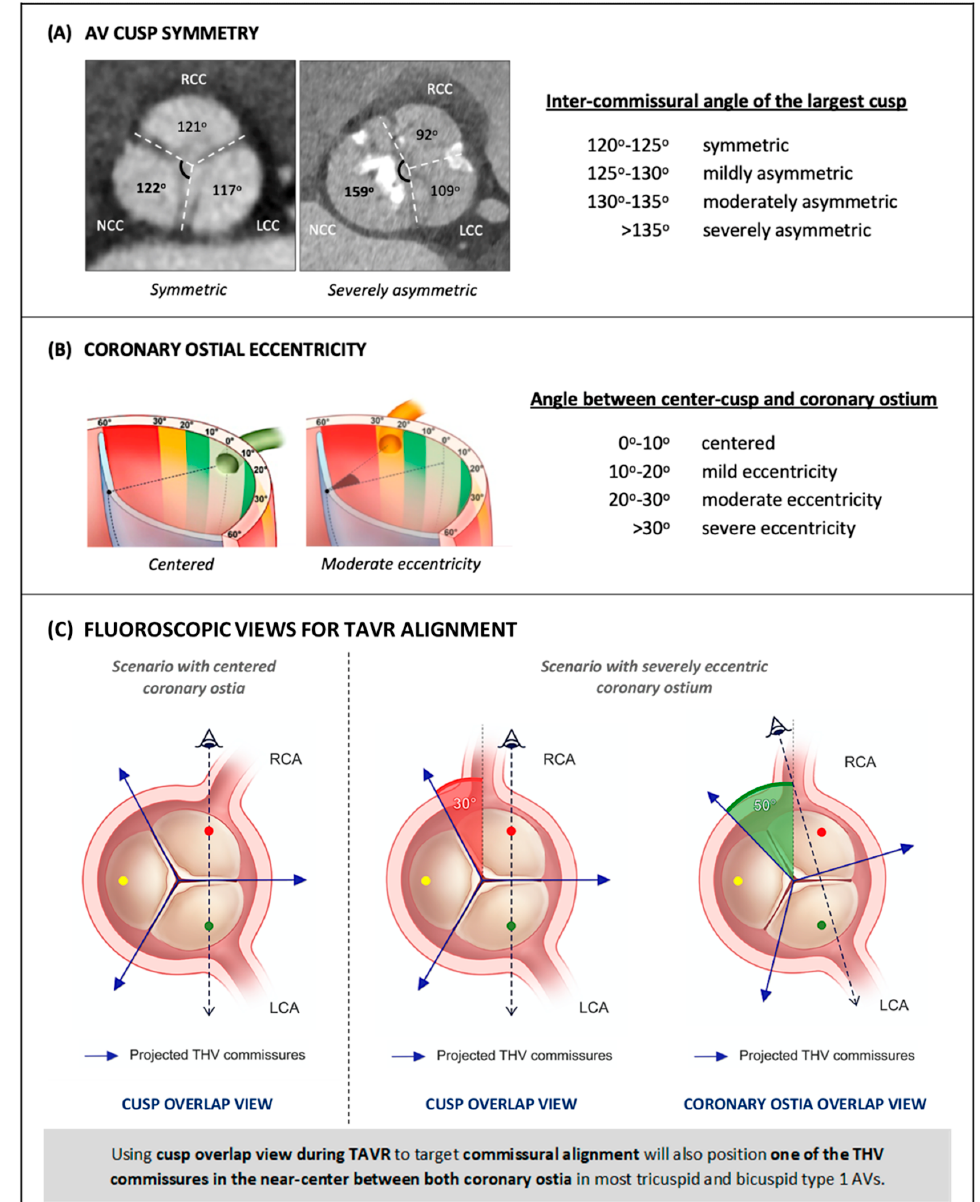
Figure 3. Proposed standardized definitions of aortic valve cusp symmetry ( A ) and coronary ostial eccentricity ( B ). ( C ): In the first scenario, on the left, commissural alignment results in an optimal angle between THV commissures and coronary ostia (60 degrees). In the second scenario, perfect commissural alignment results in a short RCA-to-commissure distance (30 degrees) due to RCA eccentricity. Using coronary ostia overlap view optimizes the commissure position in between, thereby facilitating RCA cannulation after TAVR. THV = transcatheter heart valve. RCA = right coronary artery. TAVR = transcatheter aortic valve replacement. AV = aortic valve. BAV = bicuspid aortic valve. LCA = left coronary cusp. NCC = non-coronary cusp. R/L = right-left. TAV = tricuspid aortic valve. Modified from Tang et al. [20] and Wang et al.